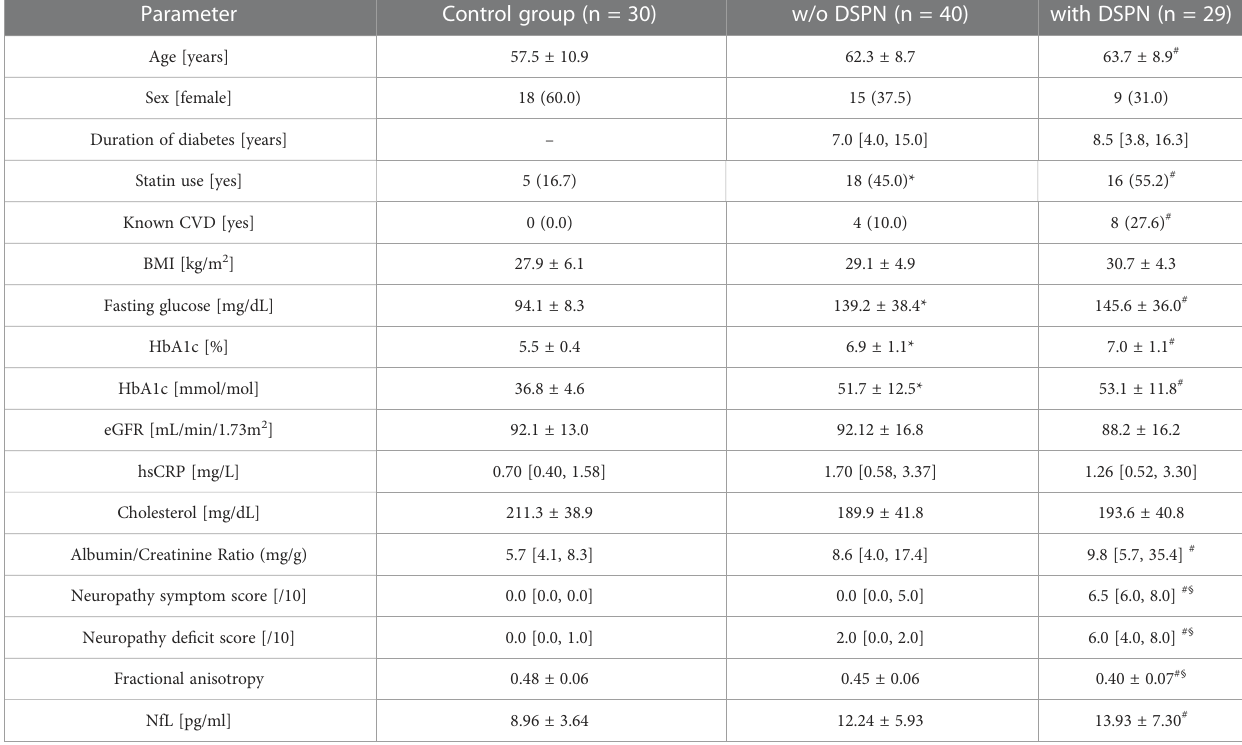
TABLE 1 Clinical characteristics of study